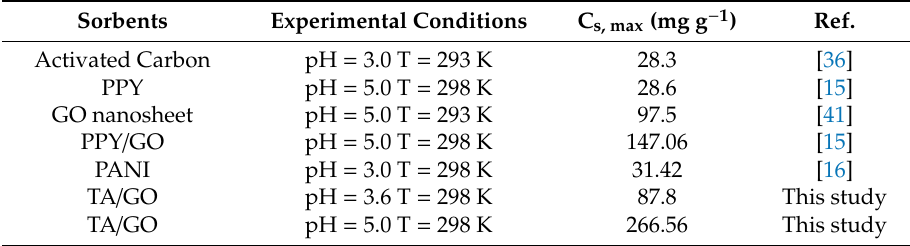
Table 4. Comparison of U(VI) sorption capacity of TA / GO composites with other sorbents.